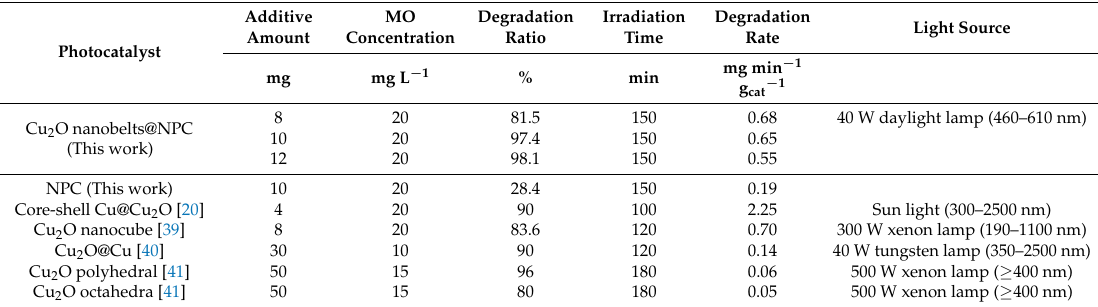
Table 1. Comparison of degradation efficiency for Cu 2 O nanobelts@NPC, Core-shell Cu@Cu 2 O, Cu 2 O nanocubes, and Cu 2